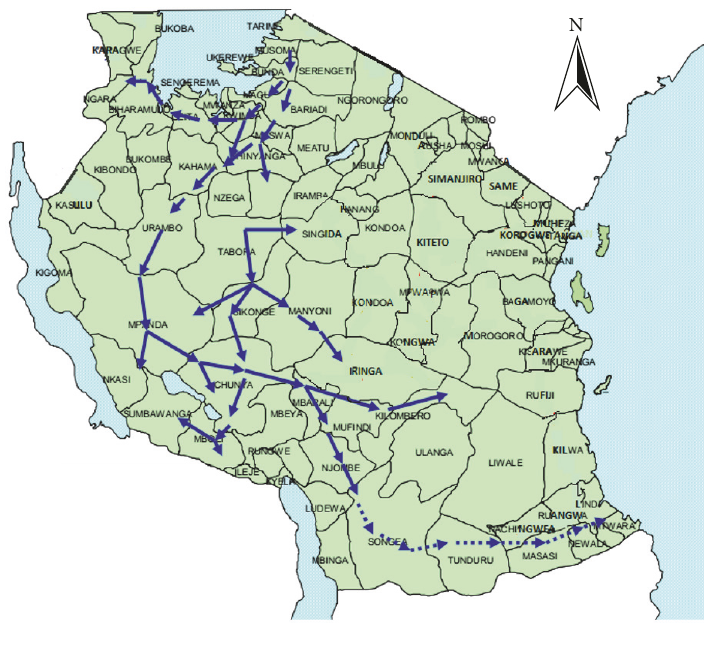
Figure 1: Southward agropastoral migration routes in Tanzania. Source: adapted and modified from Sendalo,